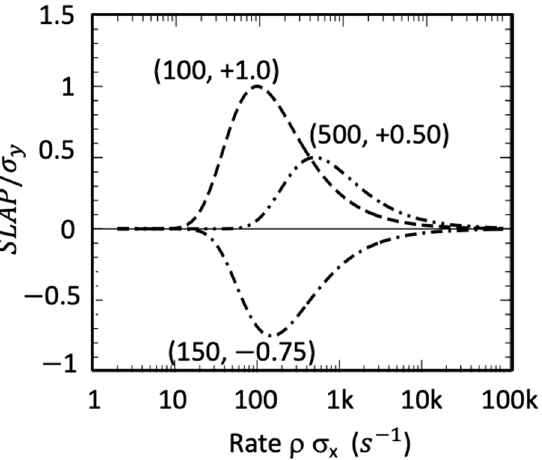
Figure 3. SLAP transforms of two majority and one minority carrier defects with decay rates and maximum values shown as ordered pairs.